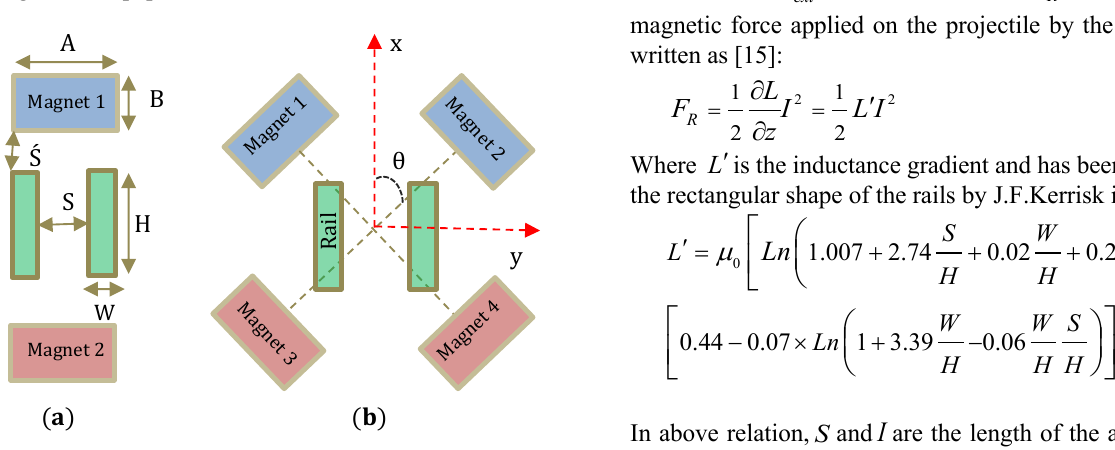
Figure 1: Two novel augmented railguns: (a) augmented railgun with 2 magnets (b) augmented railgun with 4 magnets.